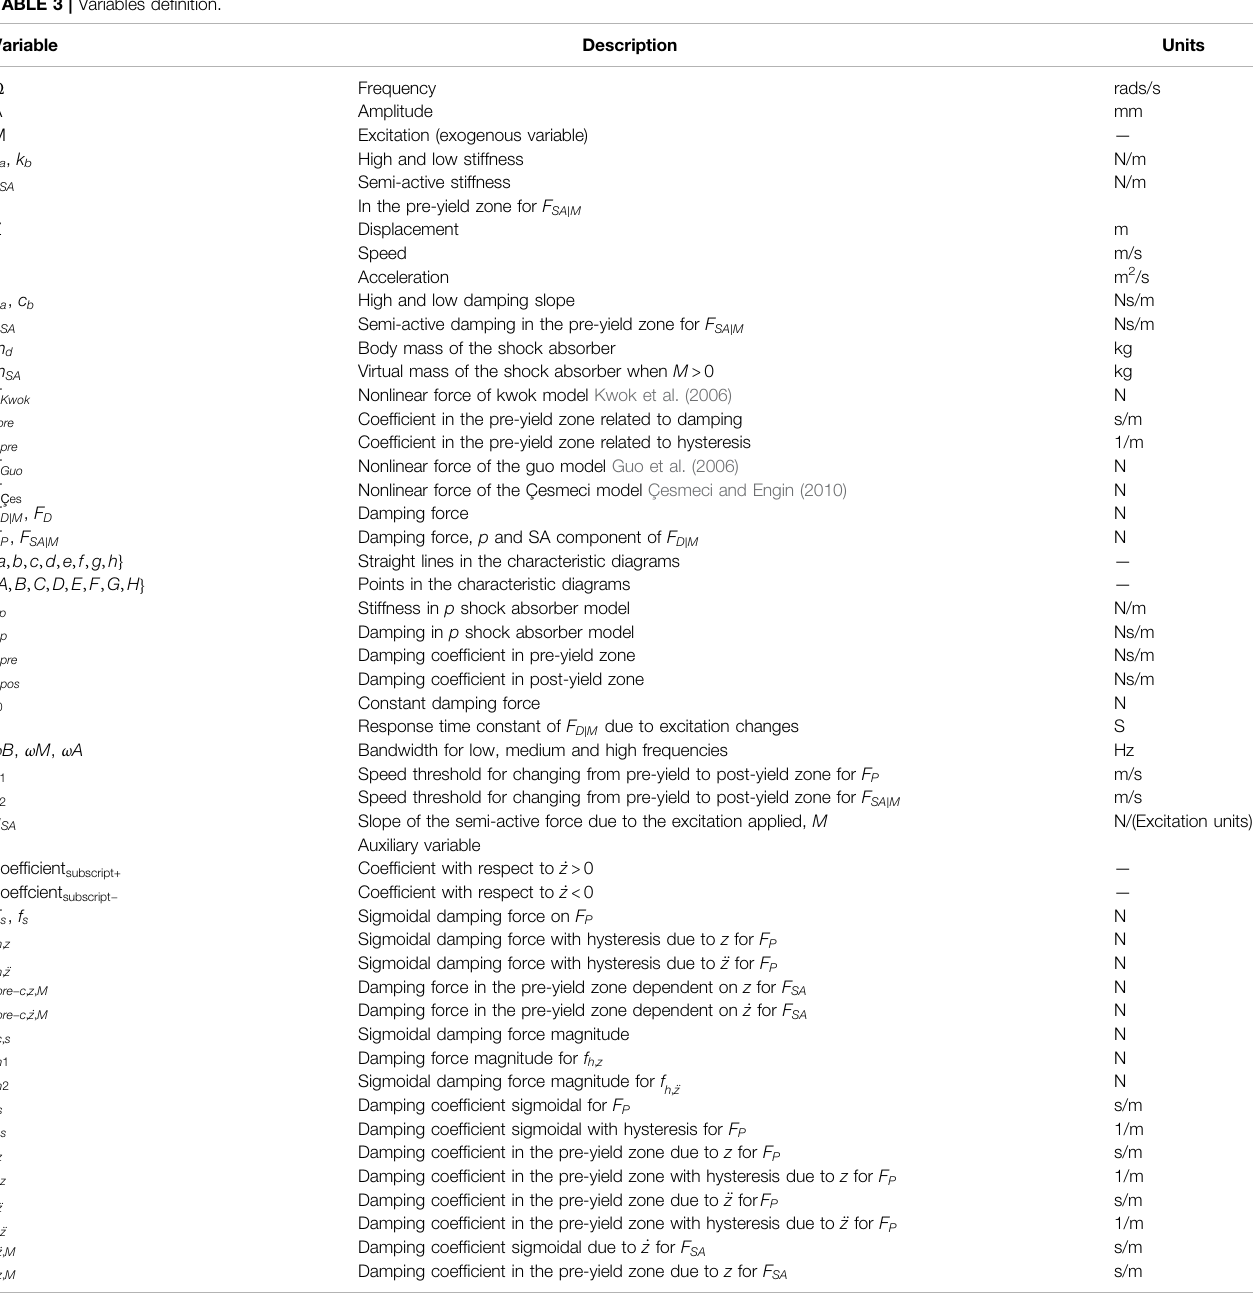
TABLE 3 | Variables de fi